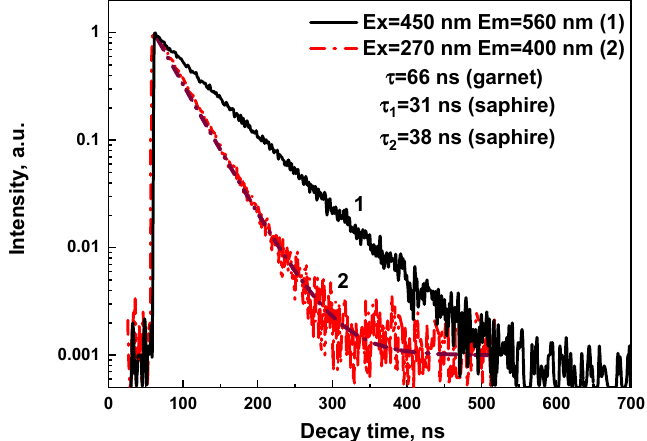
Figure 8. Decay kinetics of (Al 2 O 3 -YAG):Ce eutectic (sample 4) corresponding to the Ce 3+ luminescence in the YAG:Ce (1) and Al 2 O 3 :Ce (2) phases under excitation in the respective PLE bands at 450 nm (1) and 270 nm (2).